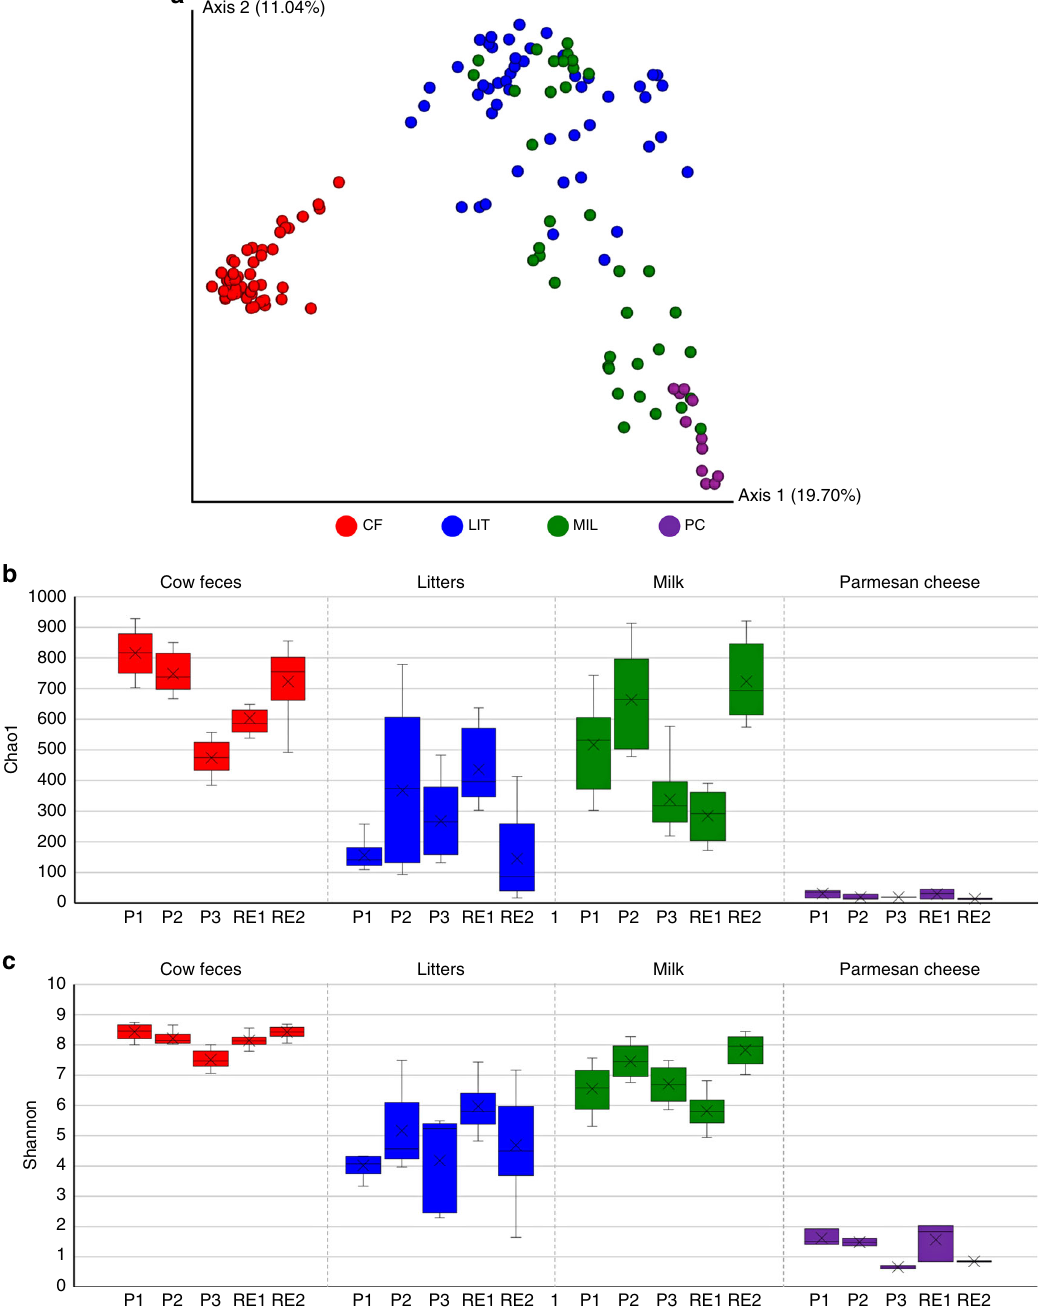
Fig. 1 16S rRNA gene-based microbial pro fi ling of the 165 samples included in this study. Panel a visualizes the PCoA representation of the beta-diversity observed with samples colored based on matrix type: cow feces (CF), litters (LIT), milk (MIL), Parmesan cheese (PC). Panels b and c show whisker plots based on Chao1 and Shannon alpha-diversity, respectively, observed for a sub-sampling of 26,666 reads. The boxes represent 50 % of the data set, distributed between the fi rst and third quartiles. The Median separates the boxes into the interquartile range, while the X represents the Mean. The lines extending vertically outside of the boxes show the outlier range. Source data are provided as a Source Data fi